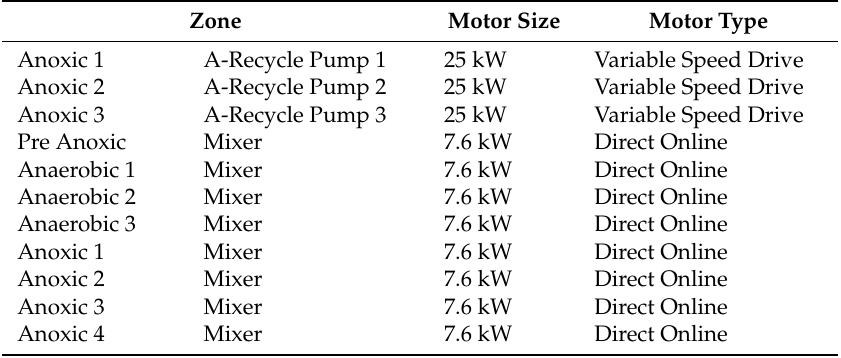
Table 1. Mixer configuration per zone in bioreactor.